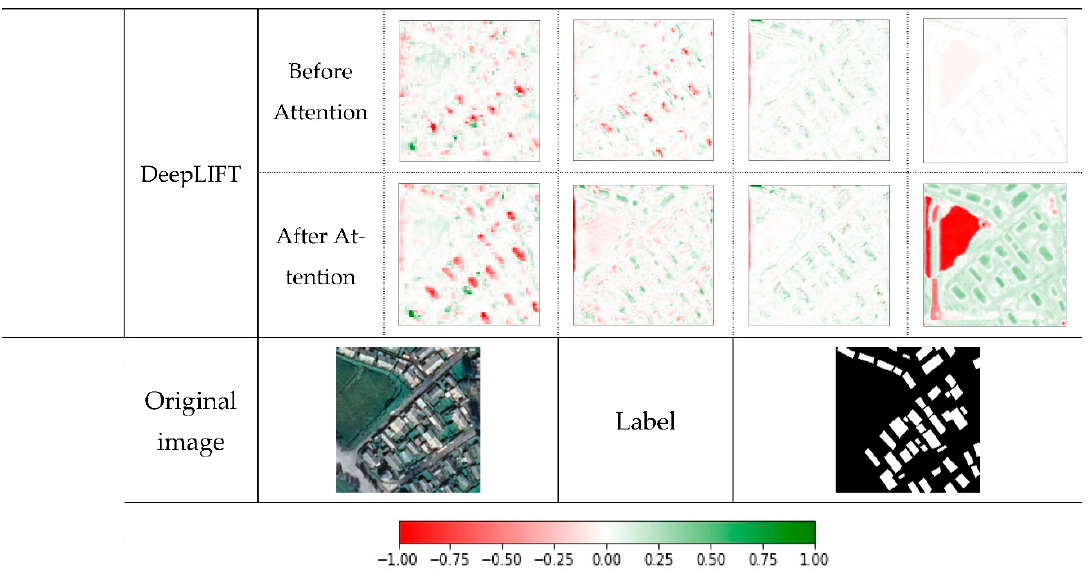
Figure 8. Visualization results of Gradient X Activation and LayerDeepLIFT before and after AMs on SegNet and Unet for WHU dataset. The numbers above the table (i.e., 1st, 2nd…) indicate the layer number of the attention in the framework.